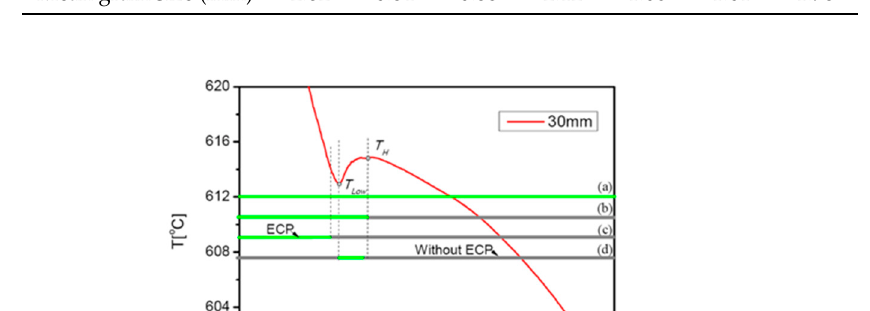
Table 1. Influence of the applied pulsed electric currents (ECP) and traveling magnetic field (TMF) on the grain size.